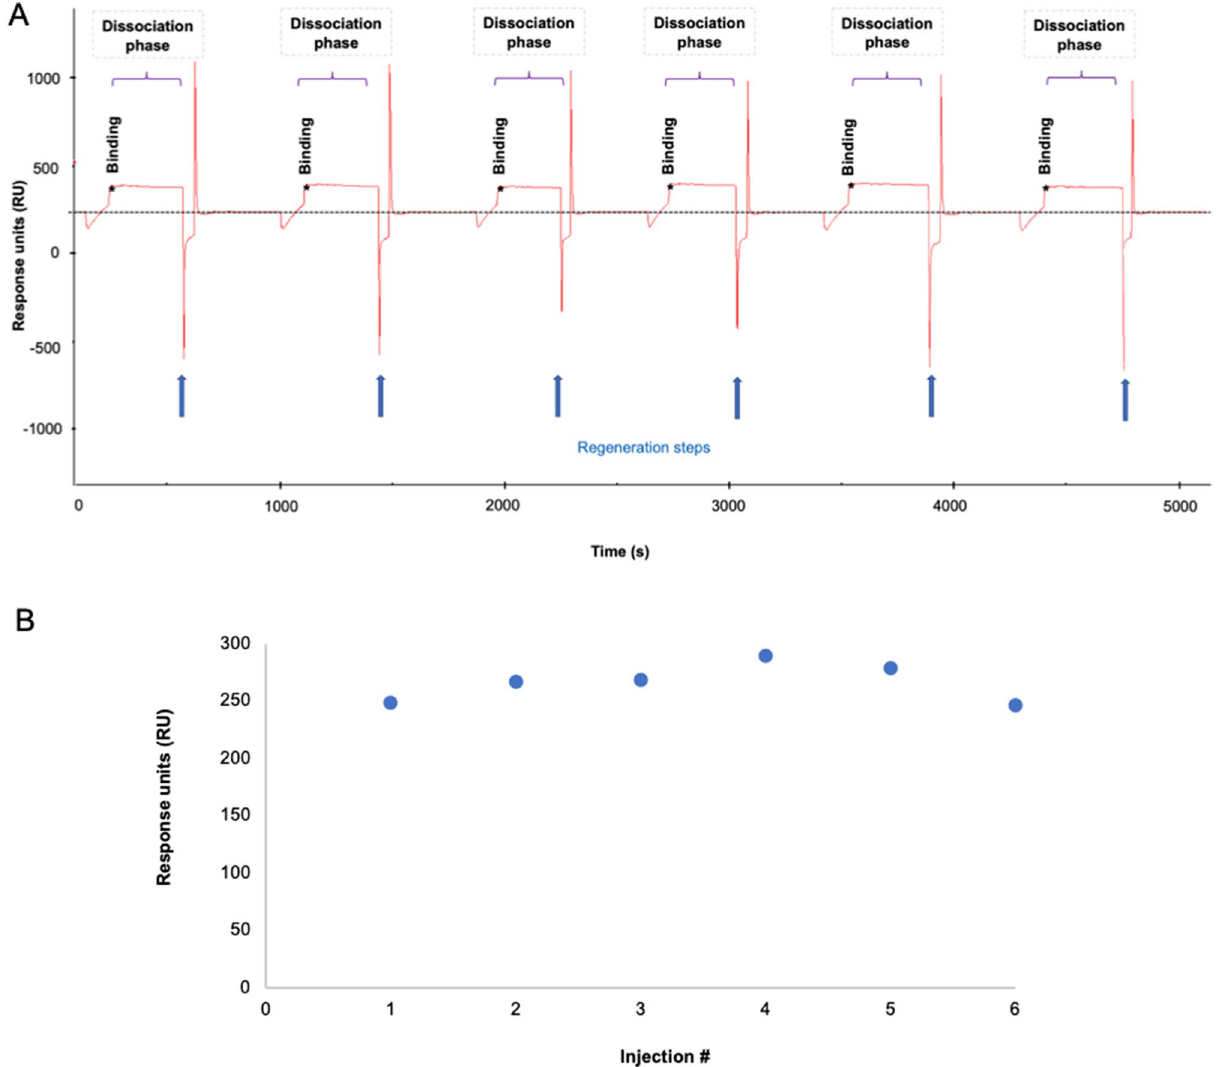
Figure 3. Efficacy of chip regeneration following repeated injections. ( A ) SPR sensorgrams of 6 consecutive injections for the same 1:8 diluted serum sample. Blue arrows indicate regeneration steps after each individual injection; ( B ) Graphical representation of SPR response obtained after each injection and its dependency with the injection number. * Binding report point refers to the maximum level of RU obtained after serum injection.